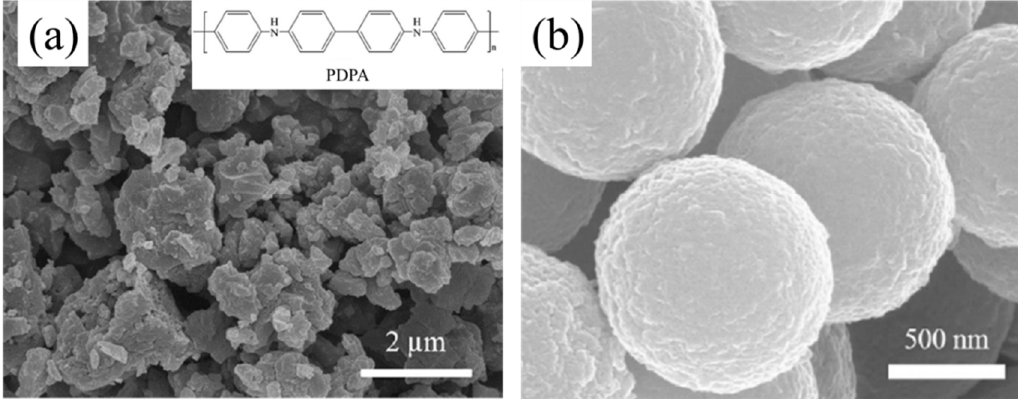
Figure 6. SEM images of ( a ) Poly(diphenylamine) (PDPA), reprinted with permission from [70].